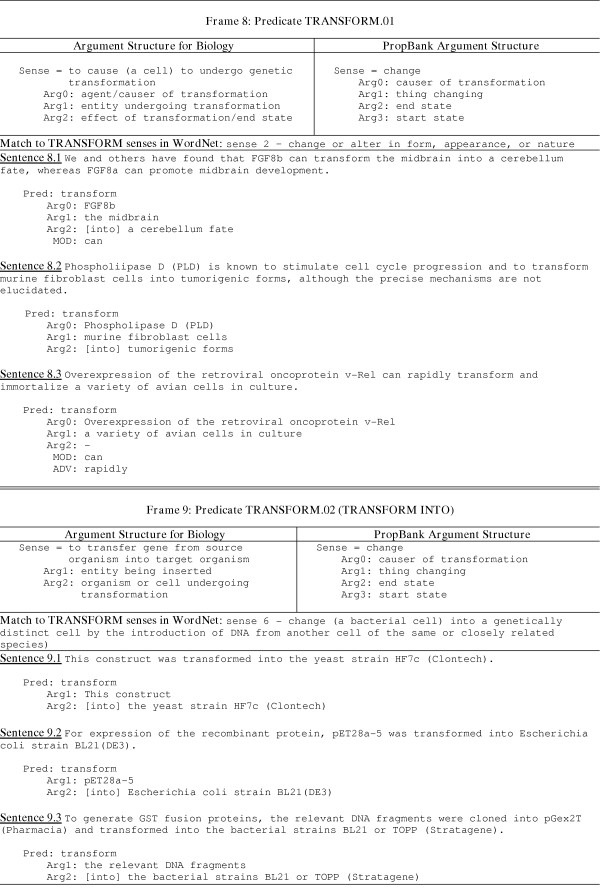
Predicate-argument structures of transform (a group D predicate) PASBio proposed two different structures for two different senses of transform found from the usage in molecular biology corpus. Predicate-argument structure as transform.01 is defined based on the usage with the meaning of WordNet [43] sense 2 – change or alter in form, appearance, or nature and transform.02 is in accordance with the WordNet sense 6 – change(bacteria cell) into a genetically distinct cell by the introduction of DNA from another cell of the same ore closely related species.